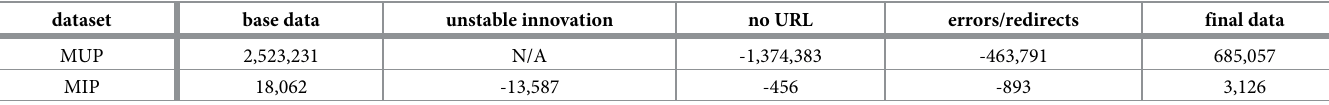
Table 1. Firms in datasets after filtering